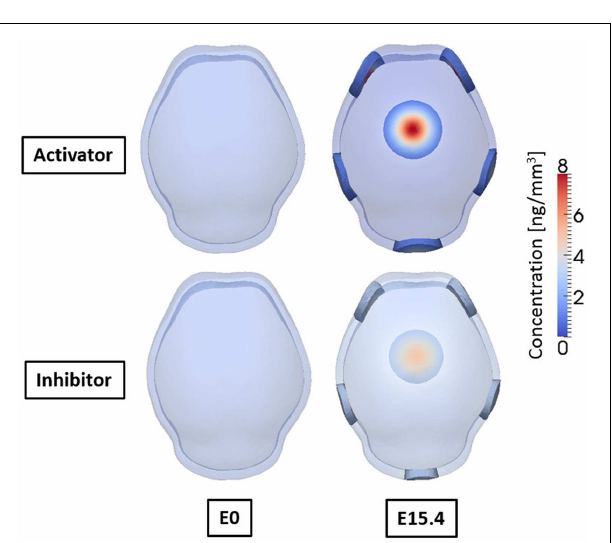
FIGURE 8 | Initial condition . A small perturbation of activator on two points on the frontal side of domain was given as an initial condition. Elsewhere the domain has homogeneous concentration of activator and inhibitor.This condition is based on the biological observation showing that mesenchymal condensations initiate at the supra orbital region just above the globe of the eye and develop into right and left frontal bones.